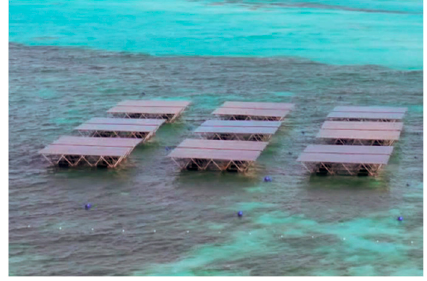
Figure 4. Solar Sea floating PV [18]. [Permission of using the figure has been requested from the copyright holder Swimsol].